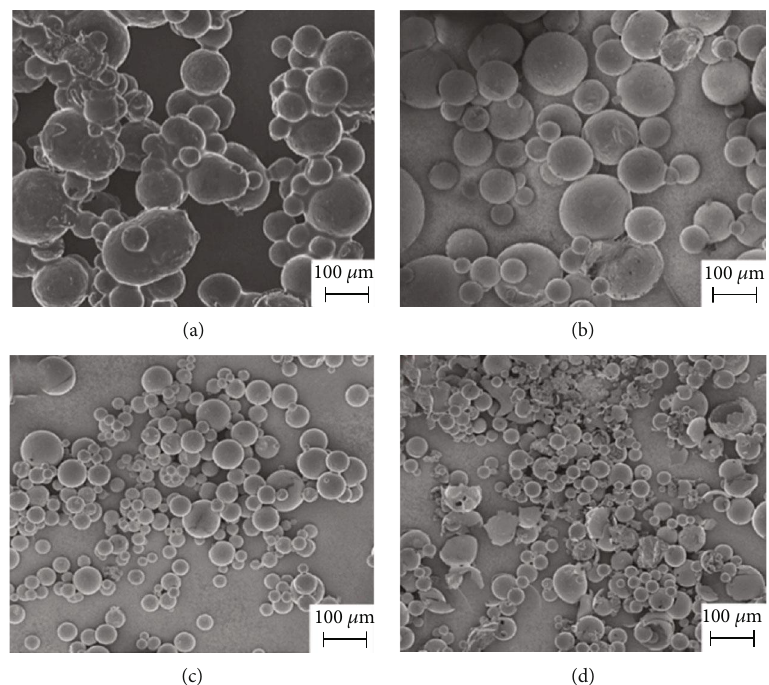
Figure 56: SEM morphologies of [BMIm]PF6@PU microcapsules prepared with increasing emulsi fi cation rate (sample 1 – 4). (a) 500rpm. (b) 2000rpm. (c) 5000rpm, (d) 8000 rpm [150].